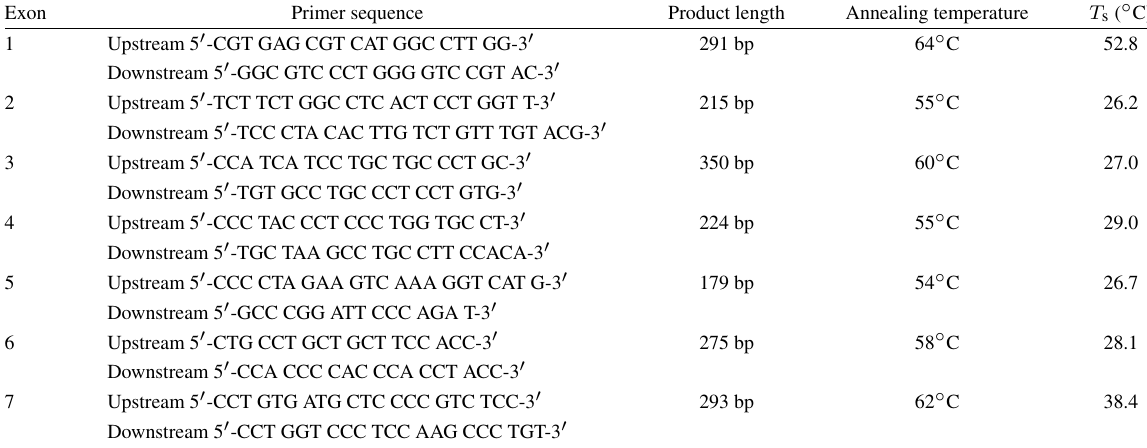
PCR primers, annealing temperatures, and amplified products for the E2F-1